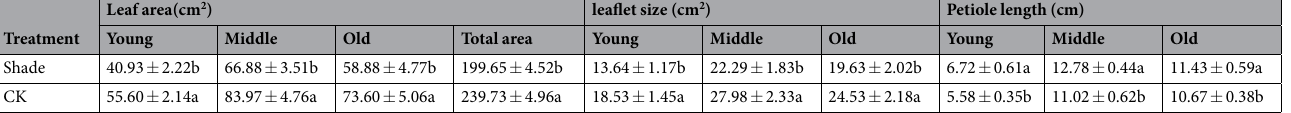
Table 1. Leaf area, leaflet size and petiole of soybean planted in shade and full sunlight (CK). Data are means ± SD (n = 4). Statistical significance assessed by Duncan’s t-test. Values followed by different letters in the same column are significantly different at the 0.05 probability level (p < 0.05).